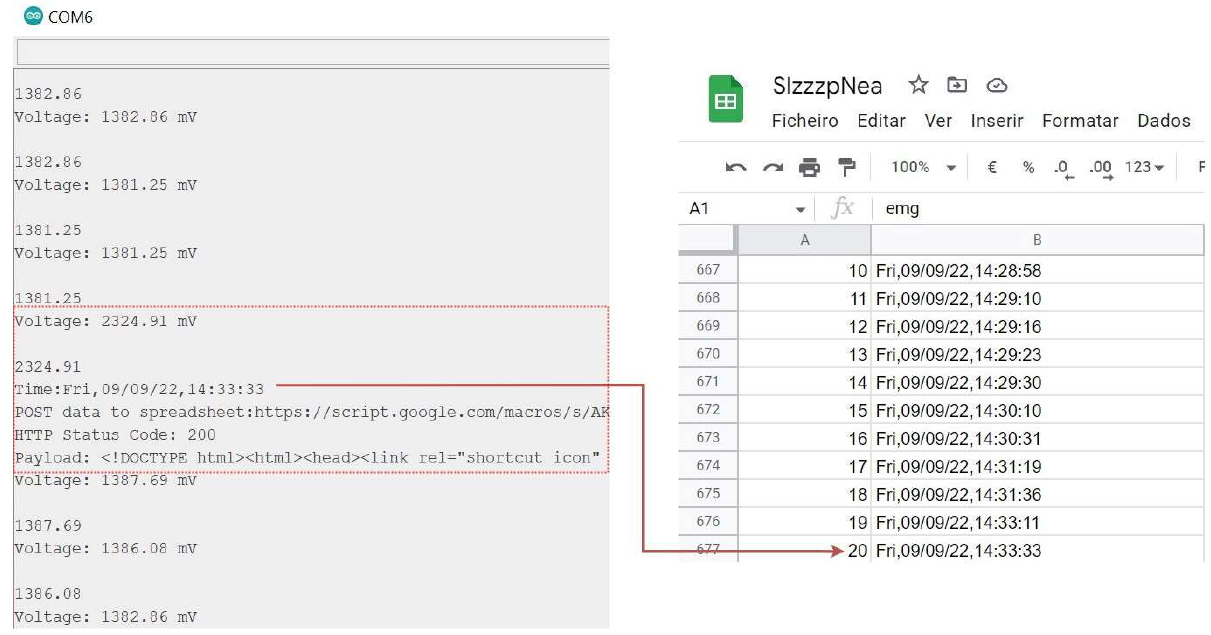
Figure 18. Process of sending the information about an occurrence to the database.